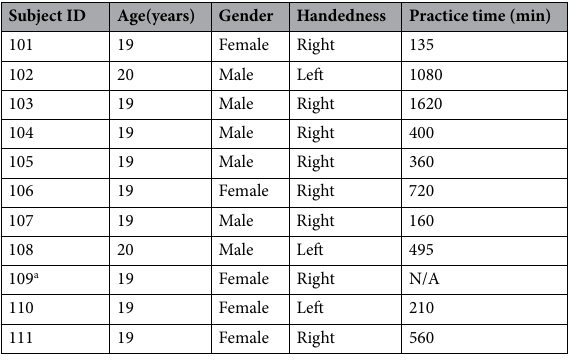
Table 1. Basic characteristics and meditation practice time of subject. a Stands for the subject who was not scanned for